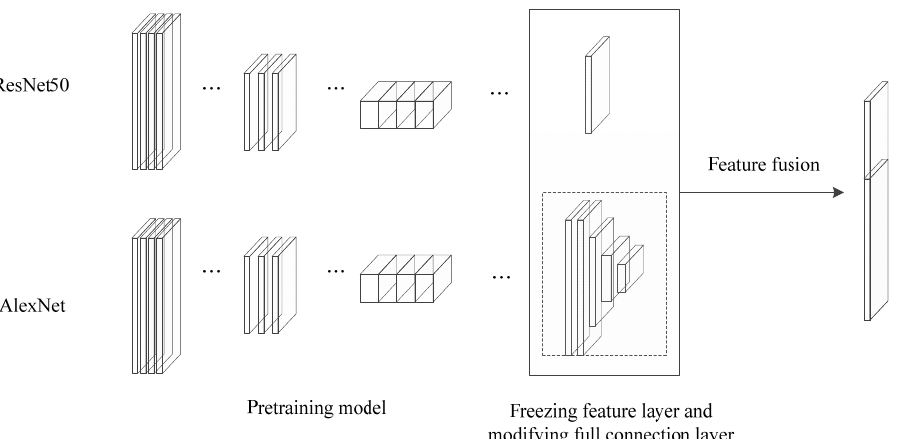
Figure 8. Optimized AlexNet full connection layer.